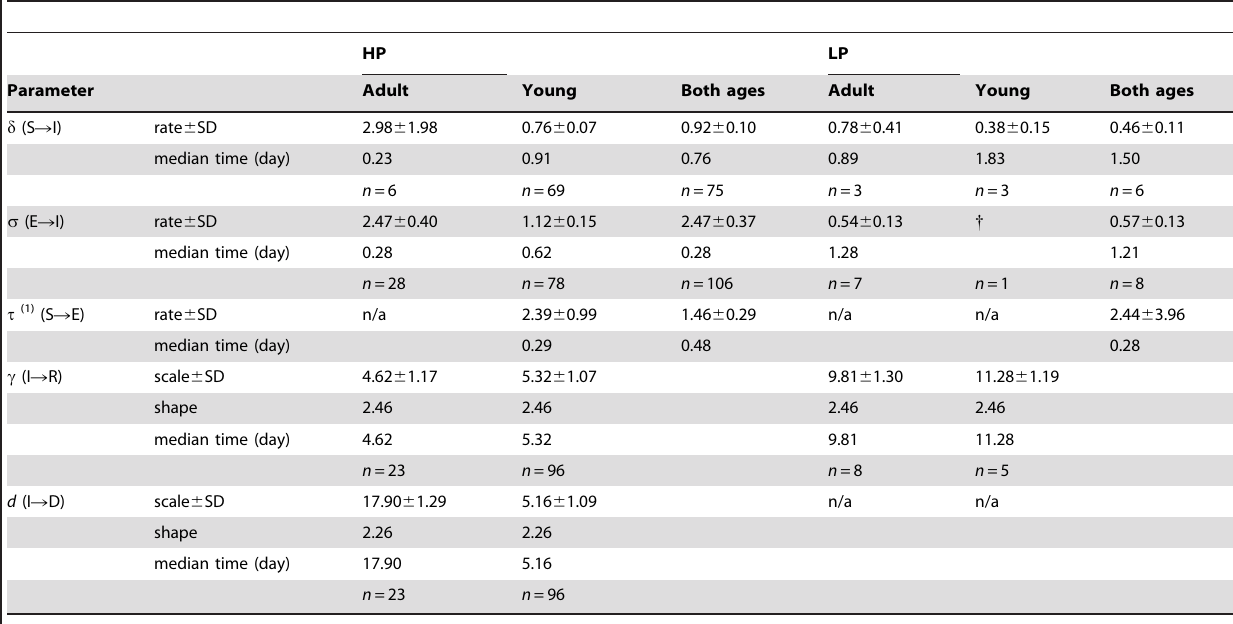
Table 1. Estimated transition rates and median time periods between epidemiological states for AI in waterfowl.